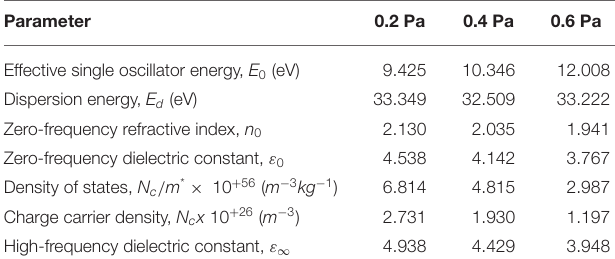
TABLE 1 | Estimation of some essential optical parameters of aluminum nitride thin films sputtered at different back pressures. Parameter